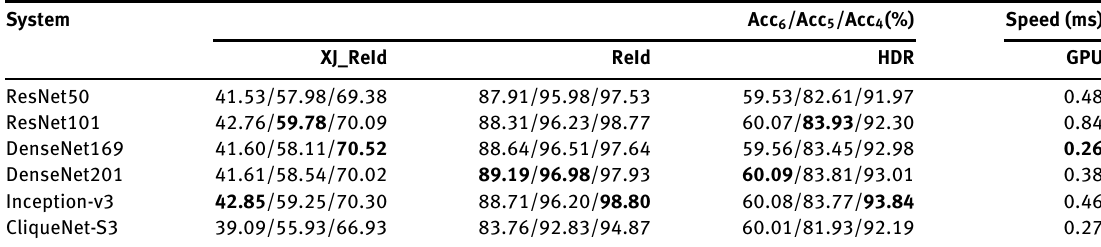
Table 1: Evaluation of Holistic LPR Methods based on Different CNN Architecture.